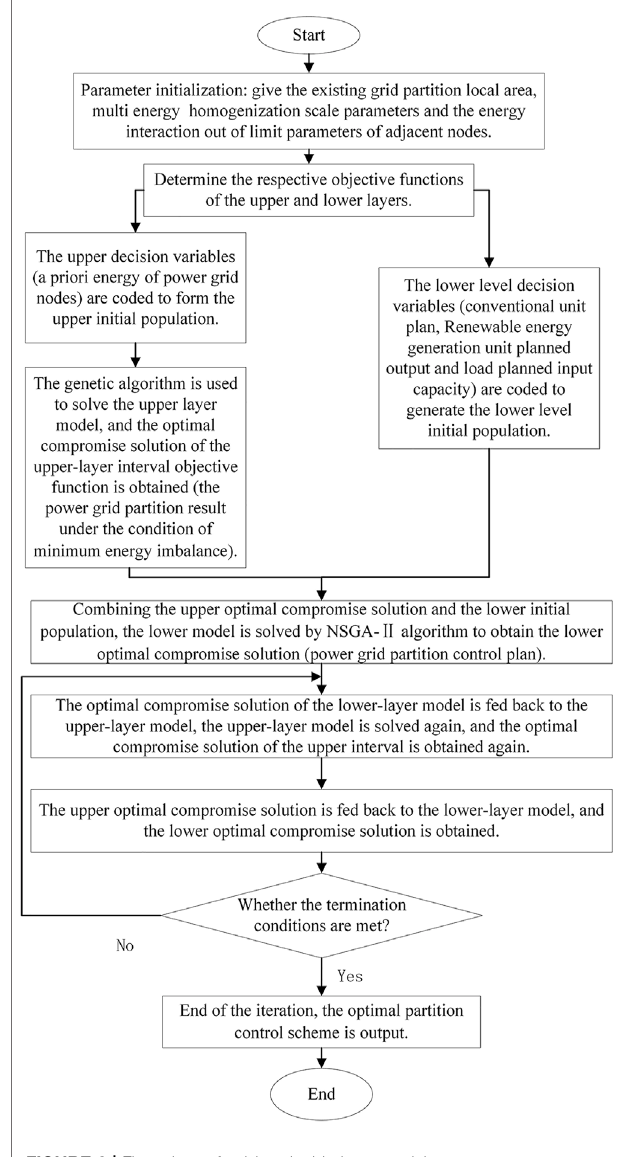
FIGURE 2 | Flow chart of solving double-layer